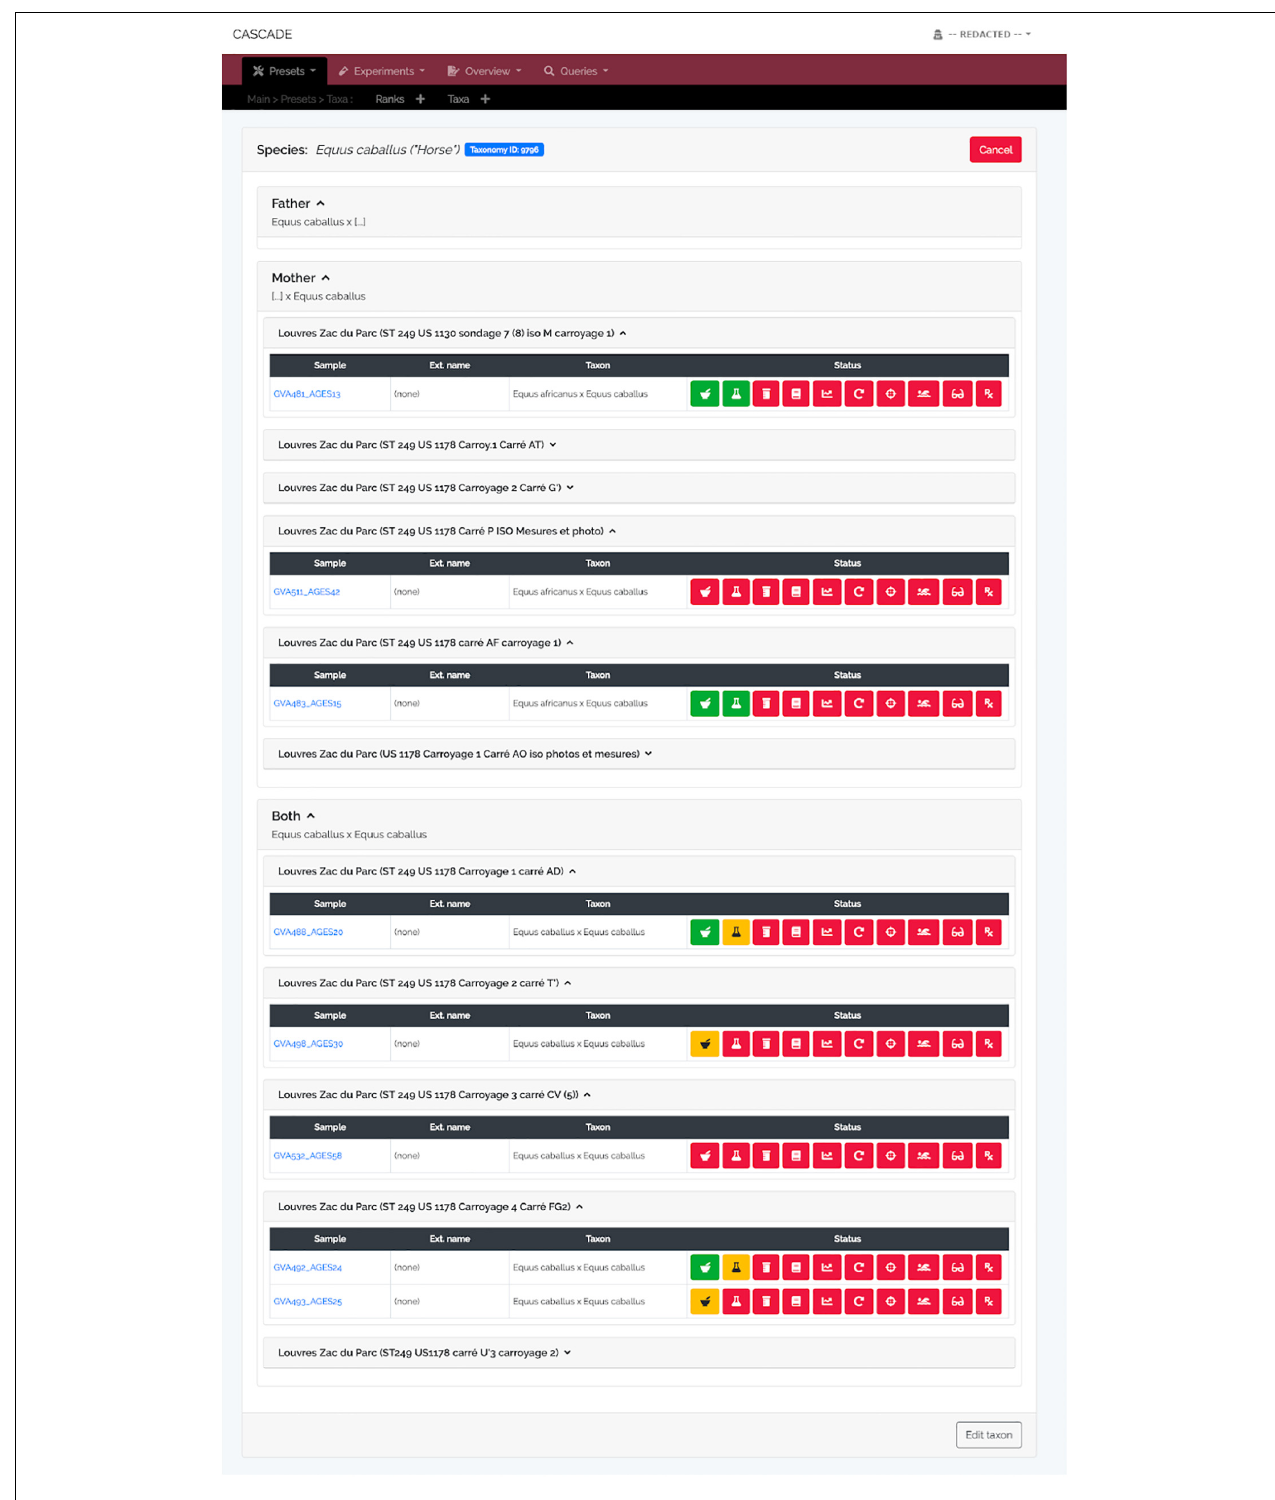
FIGURE 5 | Taxon detail view. Similar to the detail view for excavation sites, the taxon detail view lists all samples stored in CASCADE that are associated with the selected taxon. However, only those samples are listed for which there is DNA-based taxon assignment. Samples for which the taxon is estimated on the basis of other criteria (e.g., morphology) will not be listed, as this would rapidly lead to excessively large, thus, impracticable numbers of samples to be displayed. Retrieved samples are grouped by the taxon of the father, mother, and both resulting in the first two groups listing exclusively hybrids (e.g., mules and hinnies). If an NCBI Taxonomy ID was submitted together with the taxon record, a blue button at the top links directly to the entry in the NCBI Taxonomy Browser.